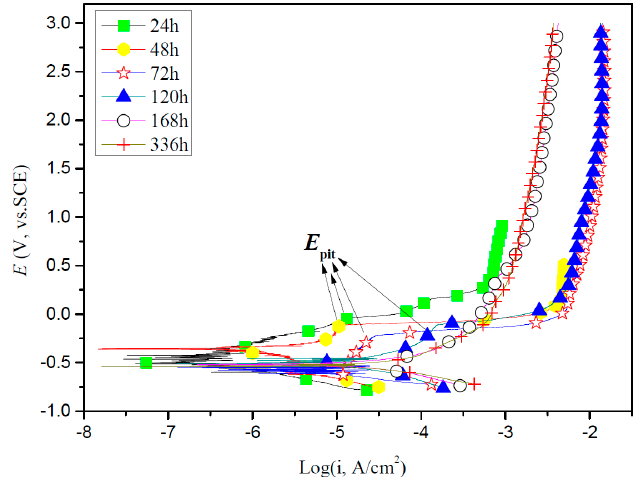
Figure 5. Potentiodynamic polarization curves of titanium exposed to enriched artificial saliva with S. sanguis at 37 °C for different time. ( E pit : pitting potential). Table 2. Tafel parameters of polarization curves for titanium in enriched artificial saliva with S. sanguis at 37 °C for different exposure times.